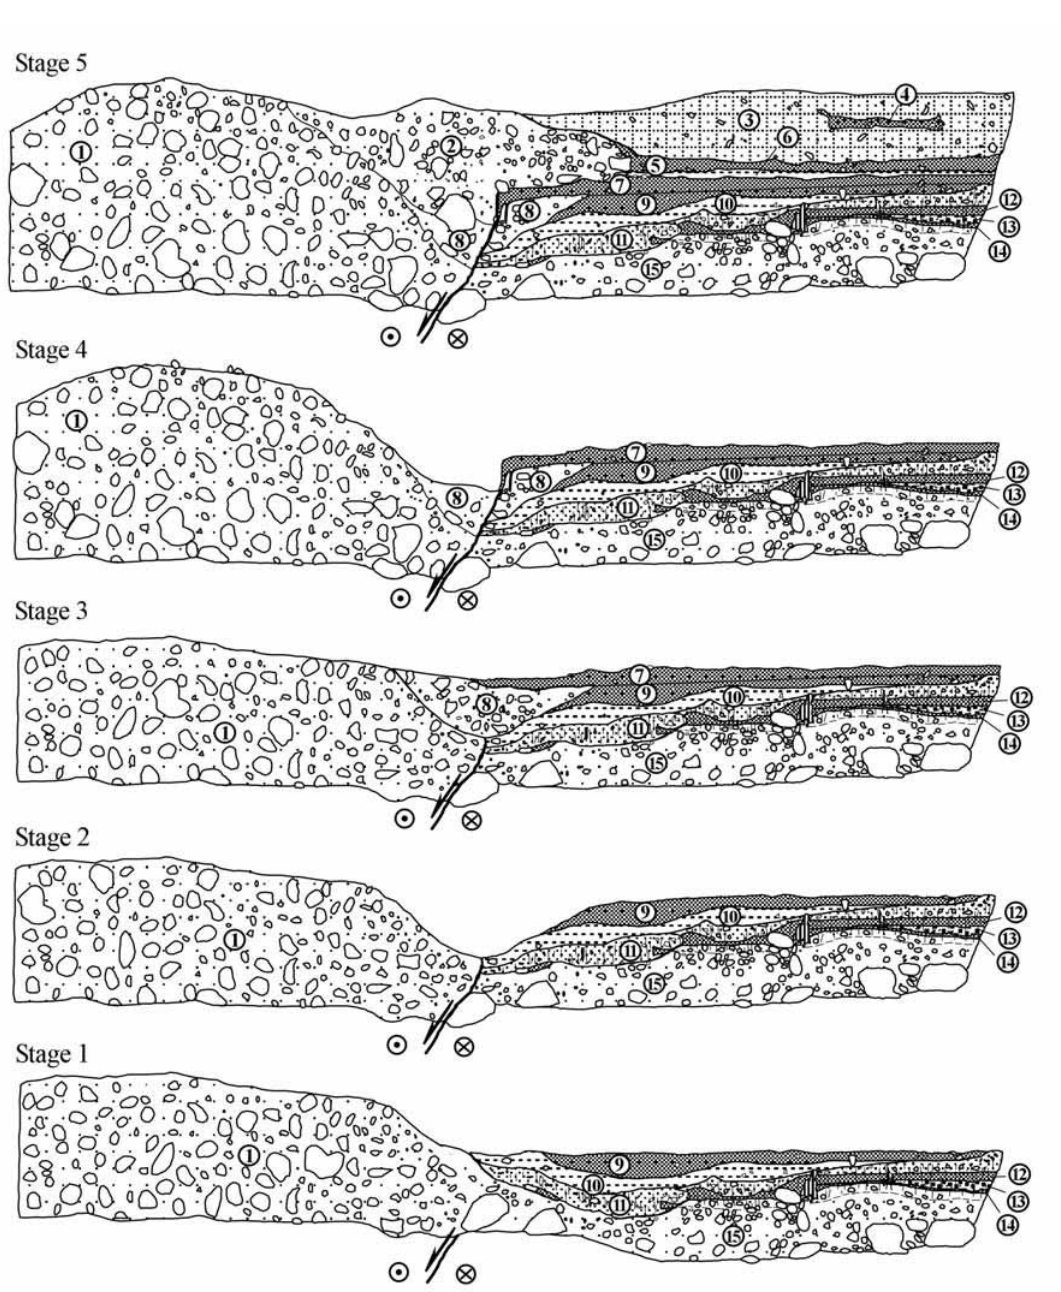
Fig. 9. A possible history for the trench in fig. 8, giving 5 stages, in which stage 2 and stage 4 correspond to two large magnitude